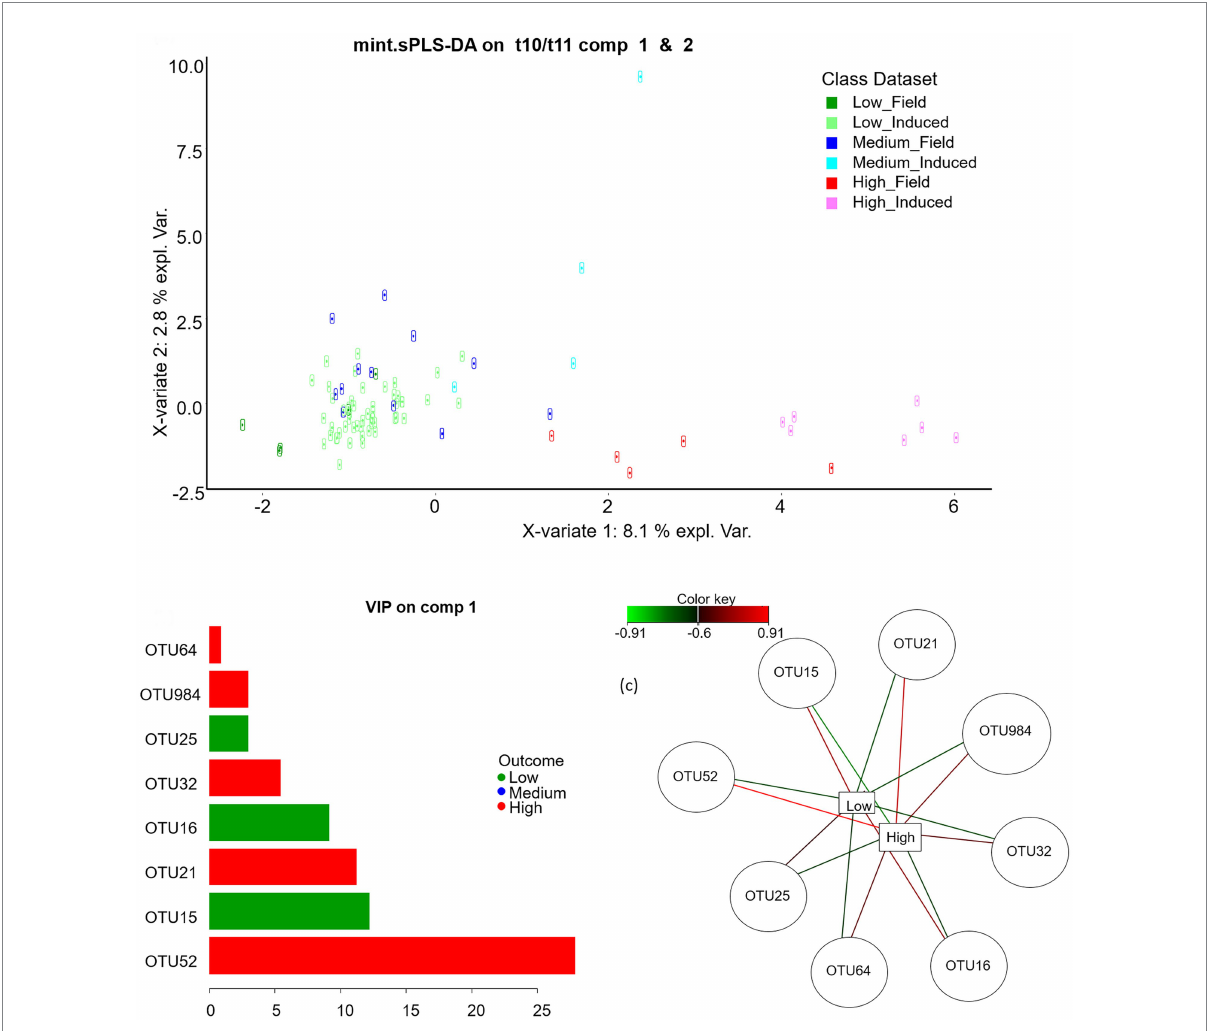
FIGURE. 3 Mint sparse partial least square discriminant analysis on rumen bacterial OTUs: sample plot on the sPLS-DA components 1 and 2 (up), variable importance in projection on component 1 (bottom left) and relevance network with a 0.6 cut-off (bottom